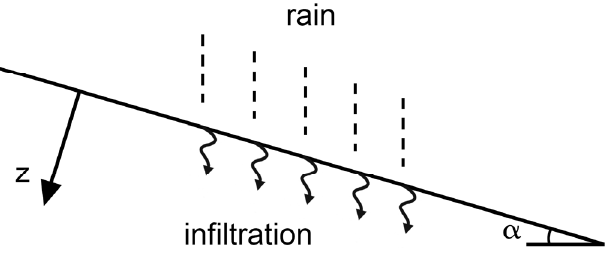
Figure 1. Scheme used for the analysis of the rain infiltration process in an infinite slope.